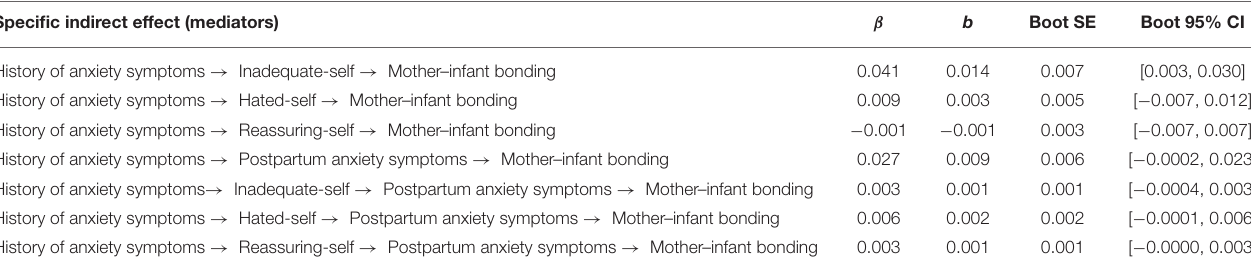
TABLE 6 | Standardized coefficients ( β ), unstandardized coefficients ( b ), unstandardized boot standard errors, and boot 95% confidence intervals of the unstandardized indirect effects history of anxiety symptoms on mother–infant bonding, through inadequate-self, hated-self, reassuring-self, postpartum anxiety symptoms (Model 2). Specific indirect effect